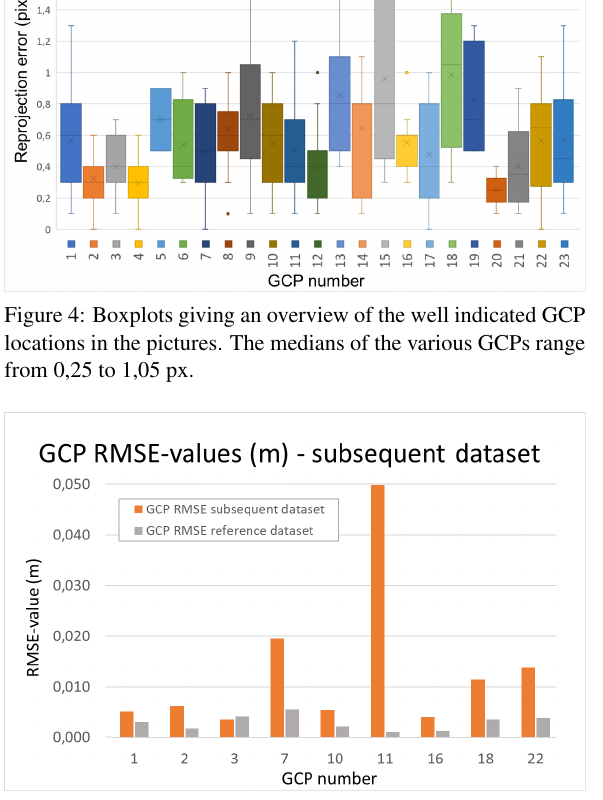
Figure 5: Column chart showing the RMSE-values of a subset of GCP locations. The error is calculated between the actual GCP position and the position in the subsequent dataset. For compar- ison, the according RMSE-values of the GCPs in the reference dataset are shown in